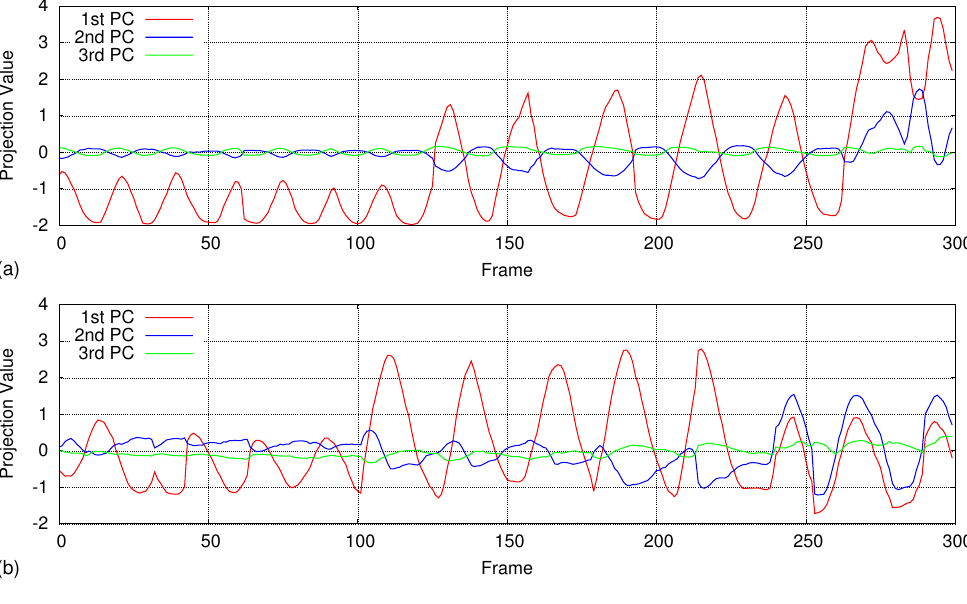
Figure 7. Projection results of 300 depth frames on the first three PCs for irregular breathing. The first two principal components show an apparent respiratory pattern, while the third one also shows a smaller respiratory signal. Graphs ( a , b ) represent two